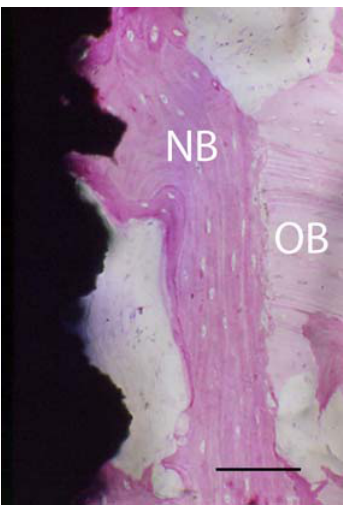
FIGURE 8 . LM image of TPS screw 3 months after surgery. Newer peri-implant bone (NB) is in direct contact with the implant surface. A marrow space with a rich vasculature appears in direct contact with the metal. Older bone (OB). Bar = 100 µm.